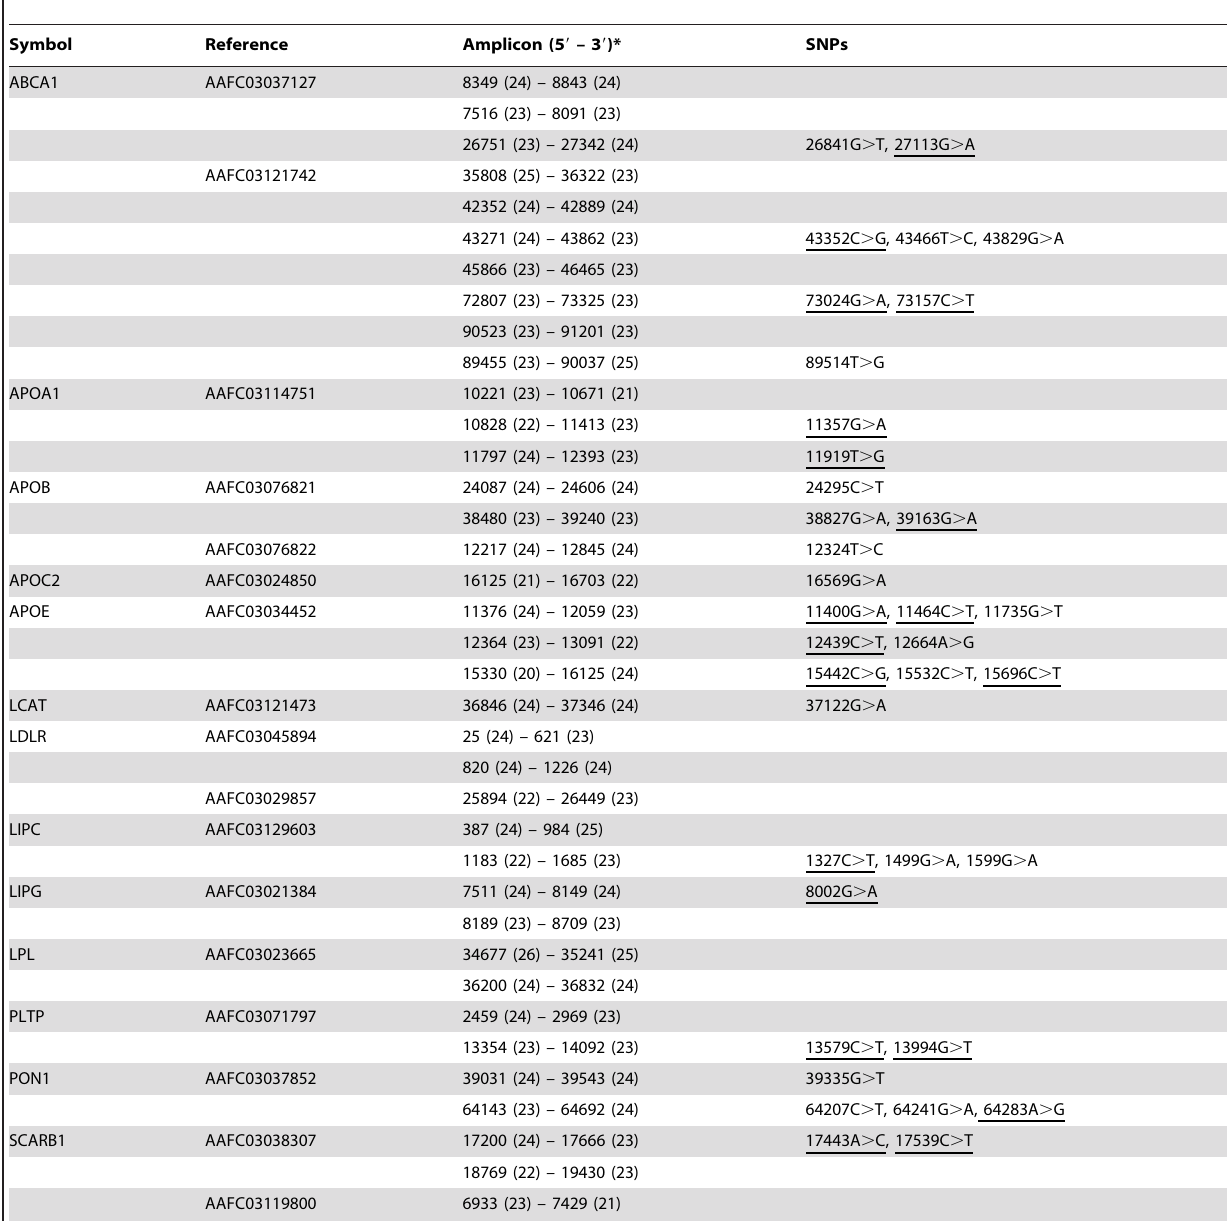
Table 1. Gene symbols, GenBank references, amplicons and SNPs discovered in the present study.